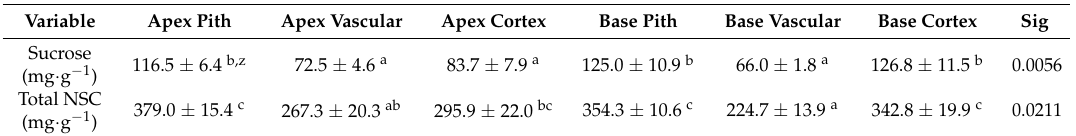
Table 2. The influence of axial and radial locations within Cycas micronesica stems on non-structural carbohydrates